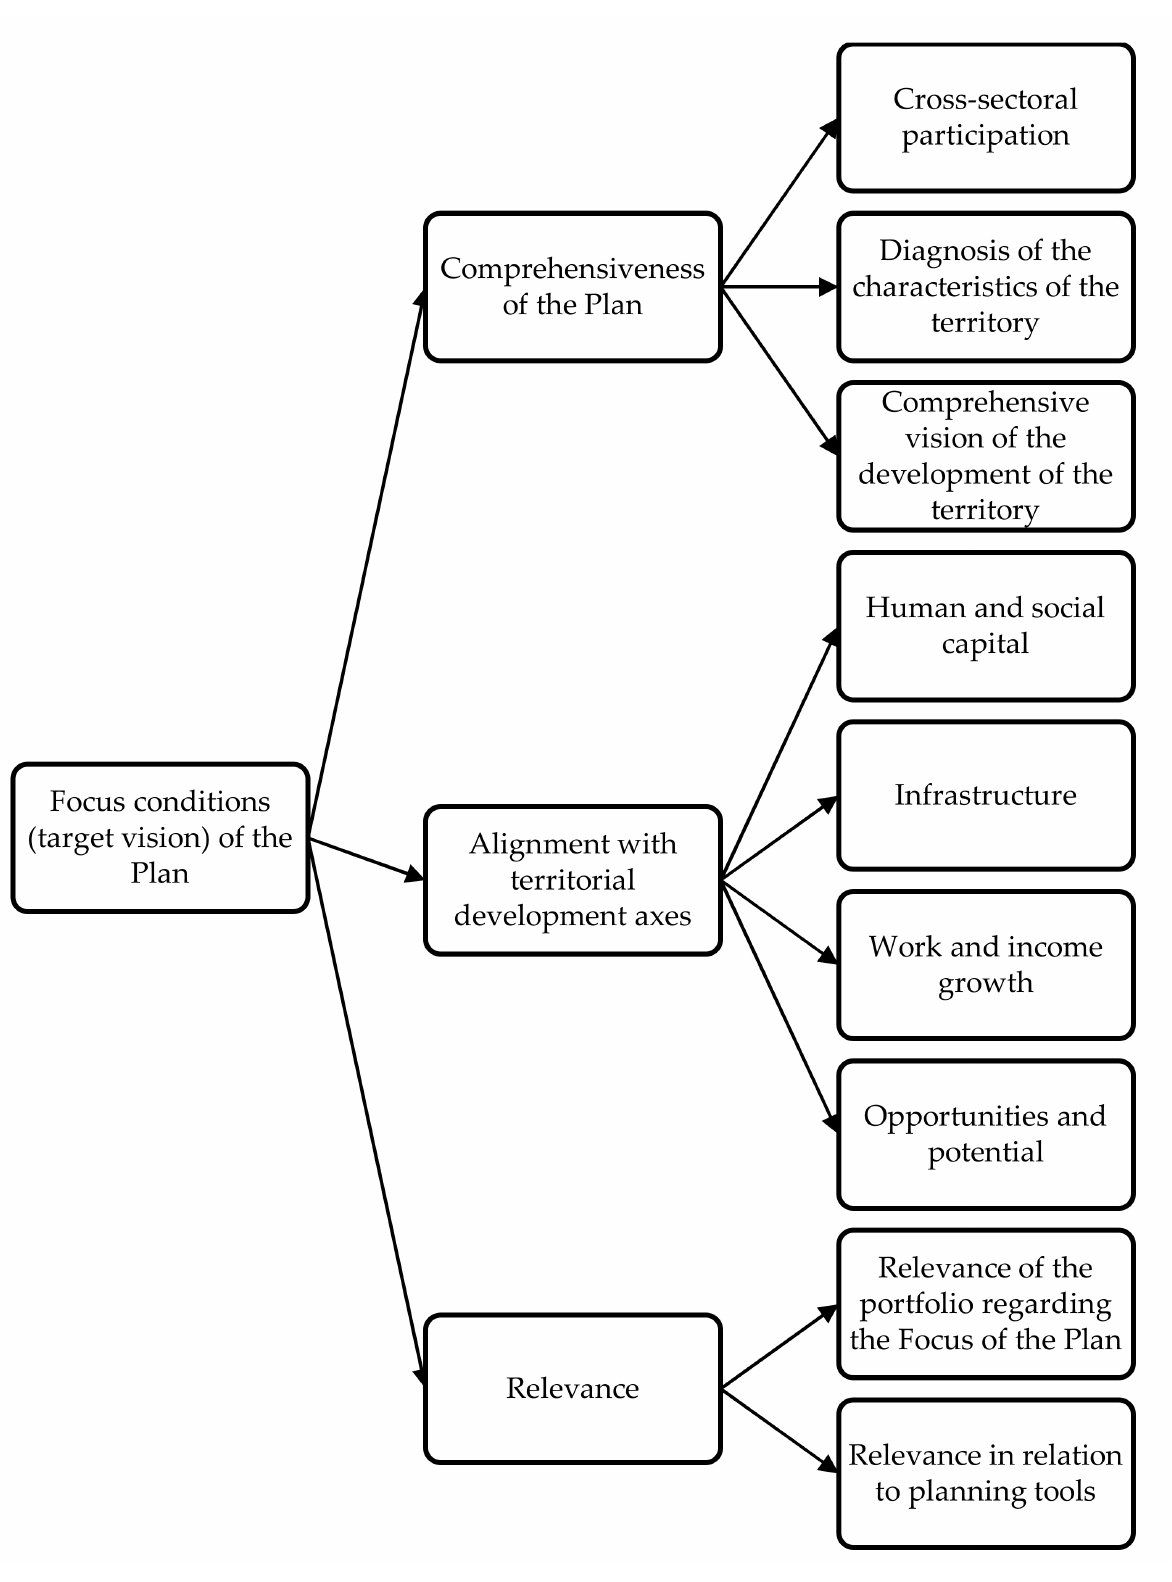
Figure 2. Criteria for the Strategic Criterion “TDP Focus